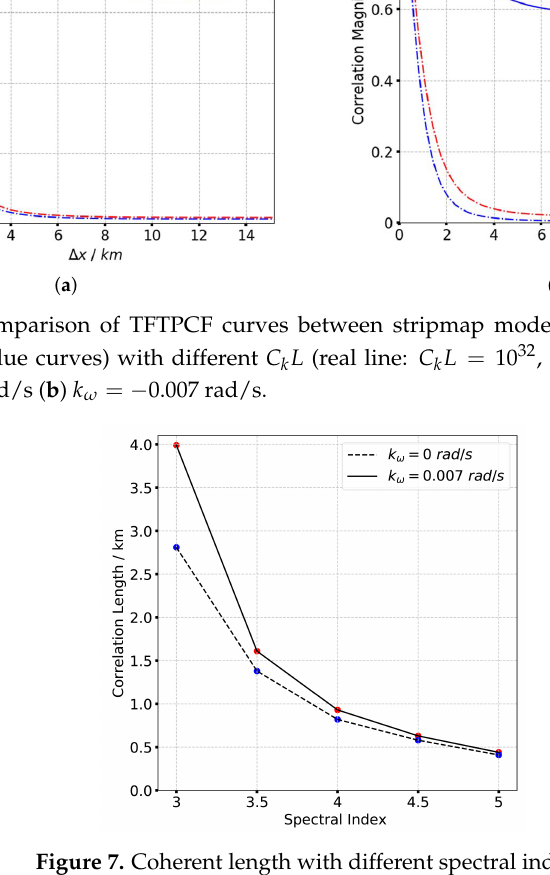
Figure 7. Coherent length with different spectral